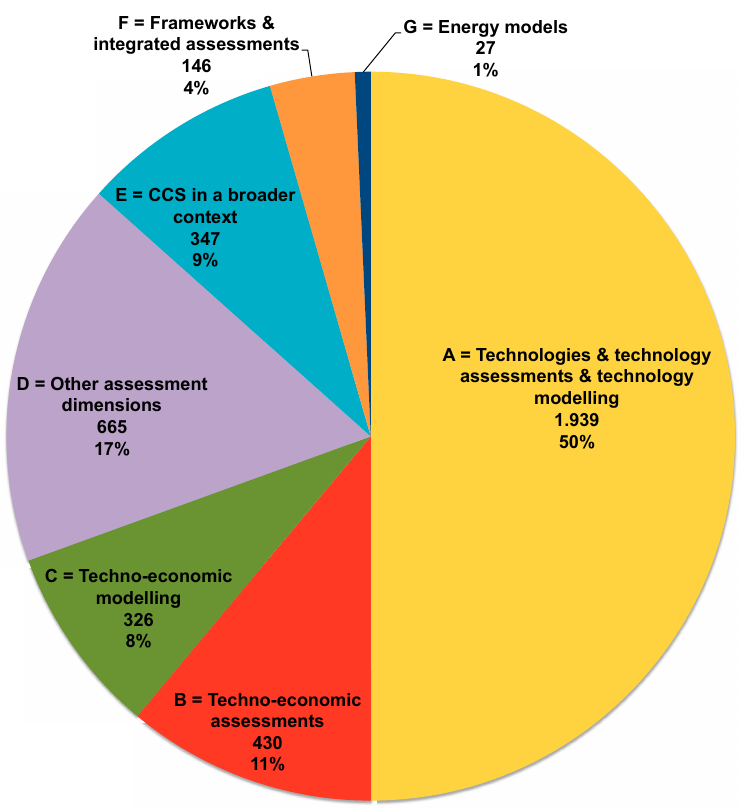
Figure 5. Meta-clusters (MC) of the overall paper network, their number of nodes, and their share as a percentage of the total number.